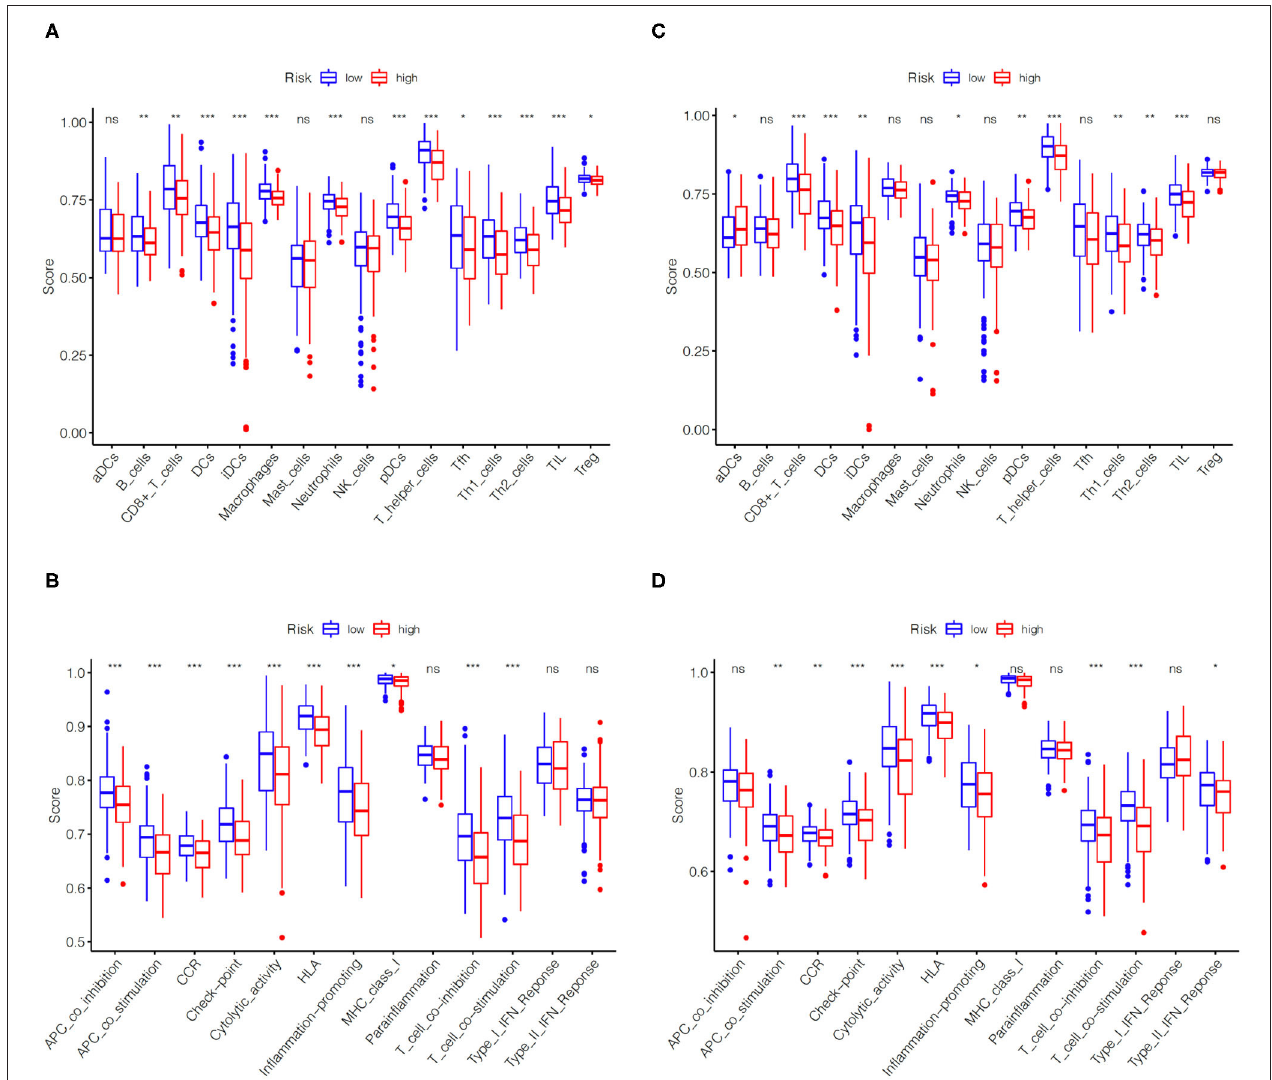
FIGURE 6 | Comparison of immune cells and immune functions of EC patients in high- and low-risk groups. Comparison of the ssGSEA scores of immune cells (A) and immune functions (B) between high- and low-risk groups in the TCGA training set. Comparison of the ssGSEA scores of immune cells (C) and immune functions (D) between high- and low-risk groups in the TCGA validation set. The statistical differences were shown as follow: ns, not significant; * P < 0.05; ** P < 0.01; *** P < 0.001.